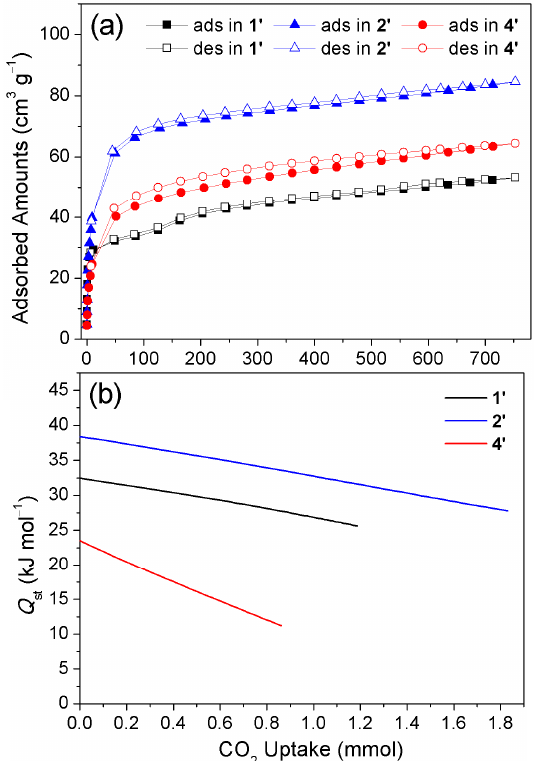
Figure 6. ( a ) CO 2 adsorption isotherms of compounds 1 ′ , 2 ′ , and 4 ′ at 195 K. ( b ) Isosteric heat ( Q st ) of CO 2 adsorption for 1 ′ , 2 ′ , and 4 ′ . Table 2. Low ‐ pressure CO 2 adsorption analyses for a series of Zn metal – organic frameworks (MOFs) at 195 K. Zn MOFs